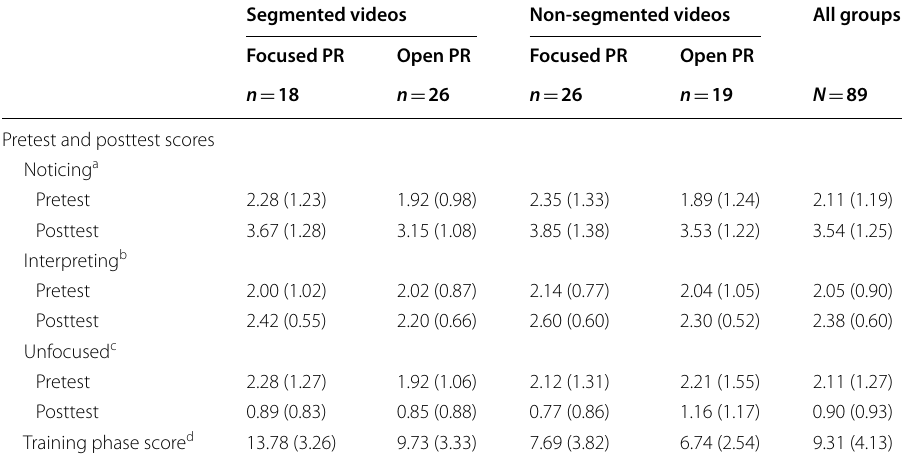
a Number of noticed relevant events; Minimum (theoretical/observed in pretest/observed in posttest): 0/0/1, Maximum: 11/6/7; b Mean quality of description and interpretation of noticed events; Minimum (theoretical/observed in pretest/ observed in posttest): 0/0/1, Maximum: 4/4/3.75; c Number of unfocused comments (not related to specific events in the video); Minimum (theoretical/observed in pretest/observed in posttest): 0/0/0, Maximum:—/6/4; d Number of references